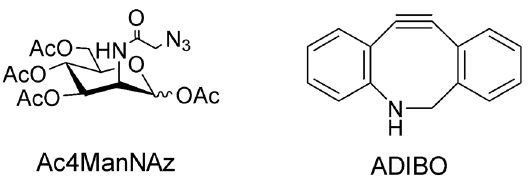
Figure 2. Structures of peracetylated N -azidoacetyl-D-mannosamine and aza-dibenzyl-cyclooctyne used in the bioorthogonal SPAAC